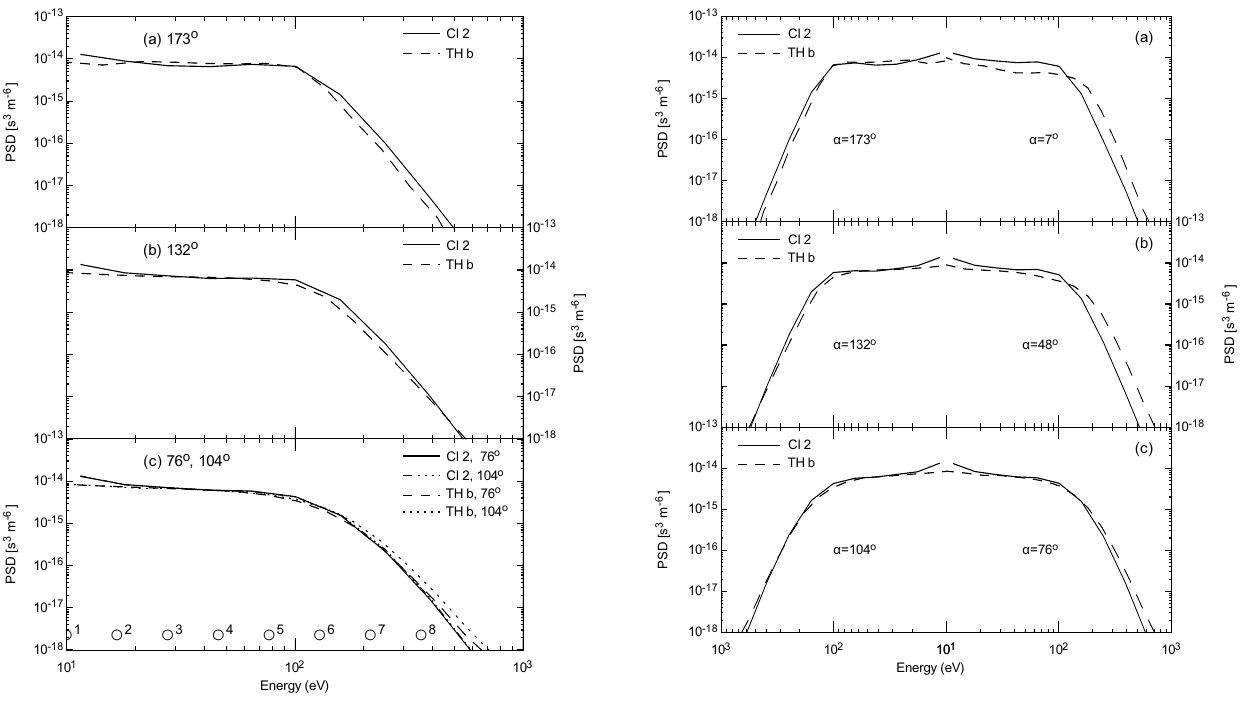
Fig. 7. Electron distributions measured at Cluster 2 and THEMIS b. Positive v k electron distributions ( α < 90 ◦ ) are on the right, negative v k are on the left. The hotter distributions for THEMIS b with α < 90 ◦ arise due larger to electron crossing locations for such